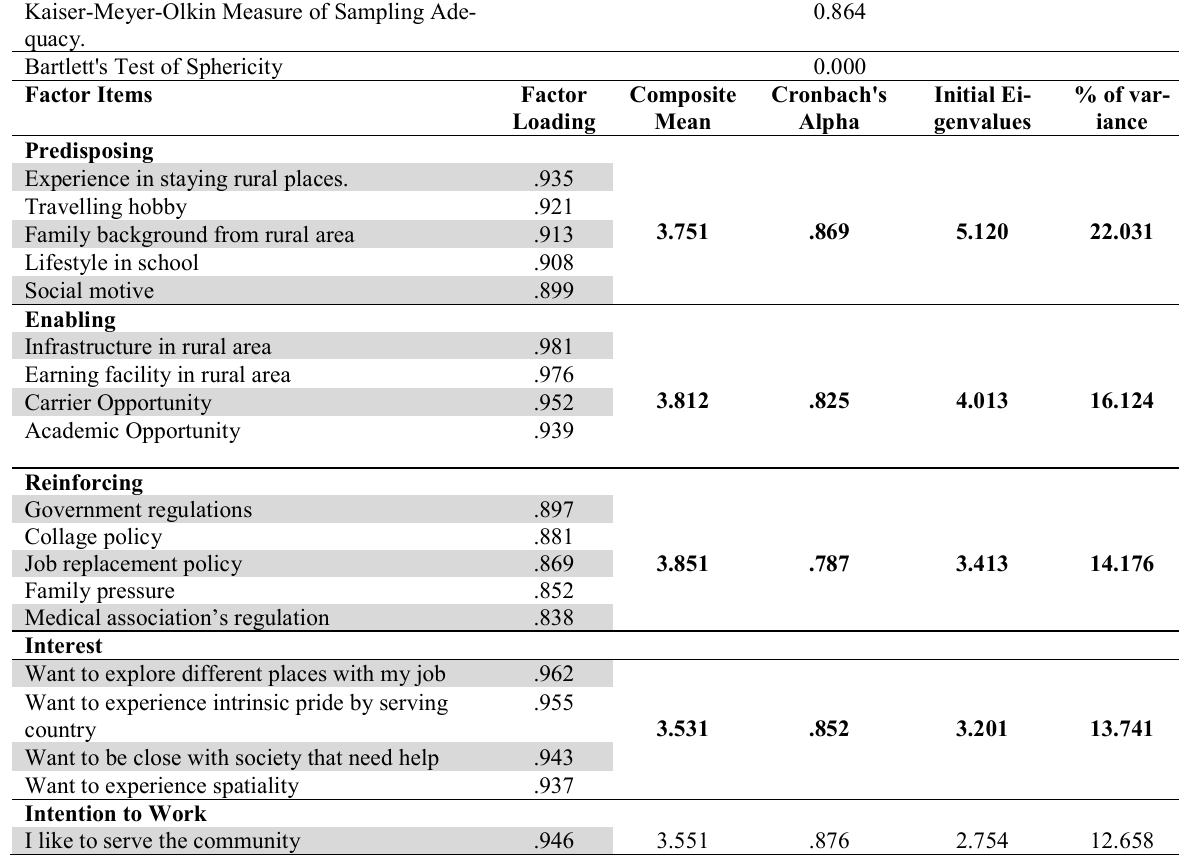
Results of Reliability and Factor